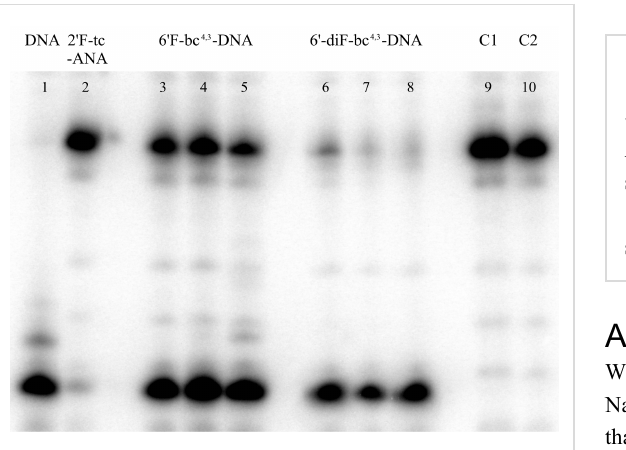
Figure 5: Hydrolysis products of the RNase H activation assay. The DNA served as positive control, whereas C1 (no antisense strand) and C2 (no enzyme) were negative